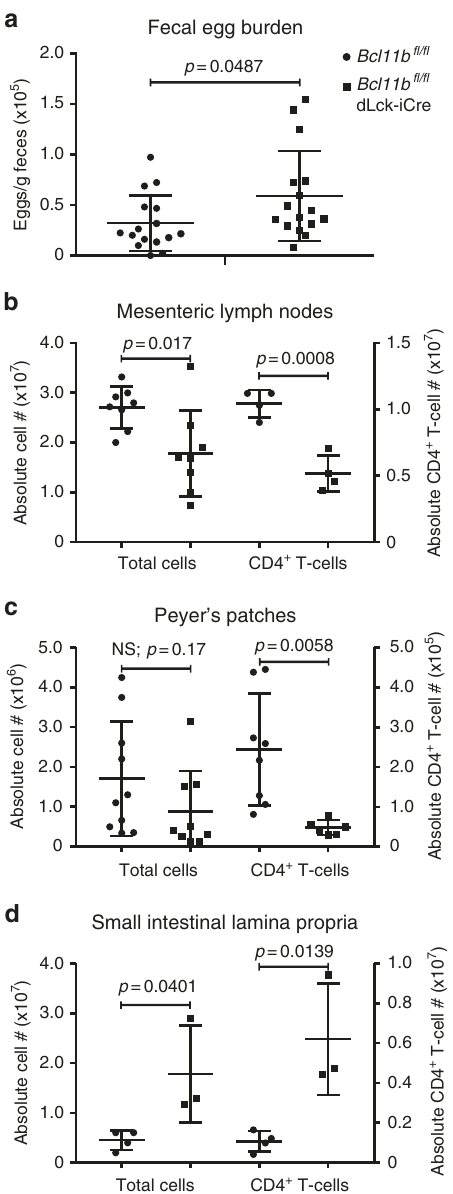
Fig. 2 Bcl11b fl / fl dLck-iCre mice have elevated helminth egg burden in feces following infection with Heligmosomoides polygyrus bakeri. a Total egg burden in feces of infected Bcl11b fl / fl dLck-iCre mice ( n = 16) and Bcl11b fl / fl control mice ( n = 16). Data are representative of nine independent